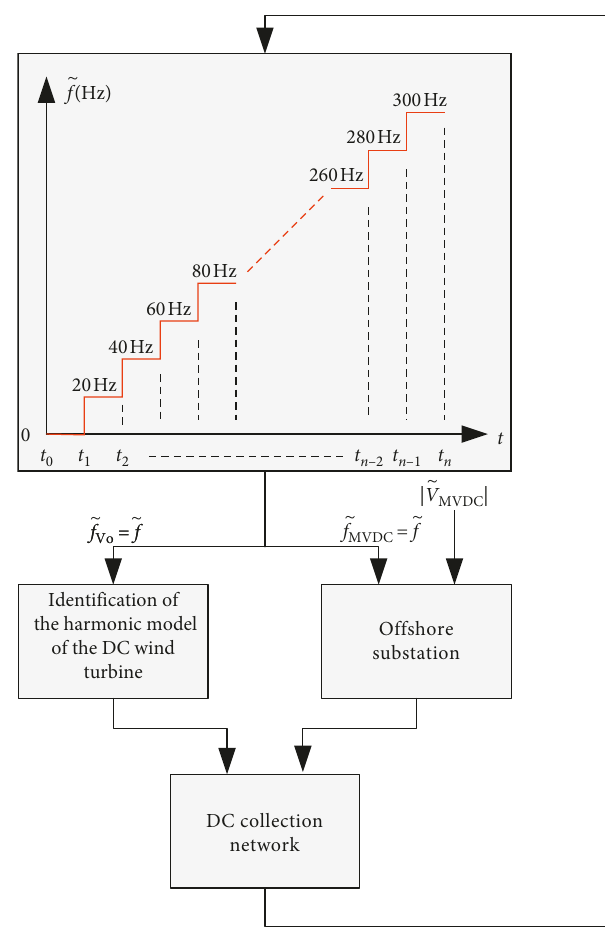
Figure 11: Frequency scan approach in the harmonic susceptibility study.